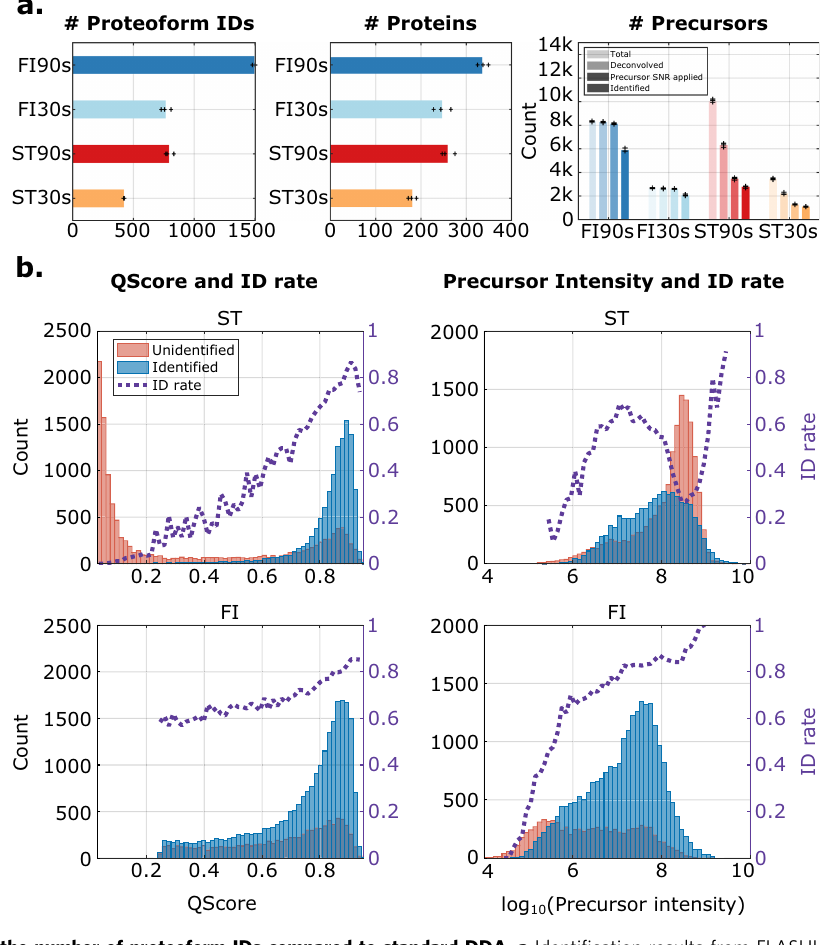
Fig. 2 FLASHIda doubles the number of proteoform IDs compared to standard DDA. a Identi fi cation results from FLASHIda as compared with the standard acquisition. n = 3 technical replicates were examined over four independent single LC-MS/MS runs from E. coli lysate sample. The four sets of E. coli lysate single runs were 90 min gradient technical triplicates with FLASHIda acquisition (FI90s), 30 min FLASHIda (FI30s), 90 min standard acquisition (ST90s), and 30 min standard (ST30s). Top-4 acquisitions were used for both methods. Each dataset was deconvolved by FLASHDeconv and identi fi ed by TopPIC at 1% spectrum and proteoform level FDR (see Methods). The left panel shows the unique proteoform ID count from each set, and the middle panel the protein count. The right panel shows the numbers of total triggered, deconvolved, precursor SNR applied, and identi fi ed (from lightest to darkest in each grouped bars) precursors from each set. The ( + ) markers show the numbers from the replicates, and the bars show their average values. It is clearly shown that FLASHIda reports almost twice more unique proteoform IDs than the standard acquisition, or alternatively similar numbers as with standard acquisition on drastically shorter gradient runs. In terms of protein count, almost 30% increase was observed. The spectrum level analysis in the right panel shows that FLASHIda runs result in far better identi fi cation rates (~75%) than standard (~35%). Source data are provided as a Source Data fi le. b The histograms for identi fi ed (blue) and unidenti fi ed (red) spectra over QScores (left panel) and precursor intensities (right) from the standard acquisition (ST, top panel) and FLASHIda (FI, bottom). For each plot, the identi fi cation rate (ID rate) in each bin is also shown as a purple dotted line. For FLASHIda runs, the distribution over QScore is truncated as precursors of QScore less than 0.25 were discarded. The top panel (ST) shows that QScore not only far better separates between identi fi ed and unidenti fi ed spectra than precursor intensity but also estimates the identi fi cation rate well in standard runs. In FLASHIda runs, QScore is underestimating the identi fi cation rate, which should be because QScore was used for the acquisition making the prediction biased. Comparing precursor intensity distributions also reveals that FLASHIda achieves almost an order of magnitude wider dynamic range than the standard acquisition. Source data are provided as a Source Data fi